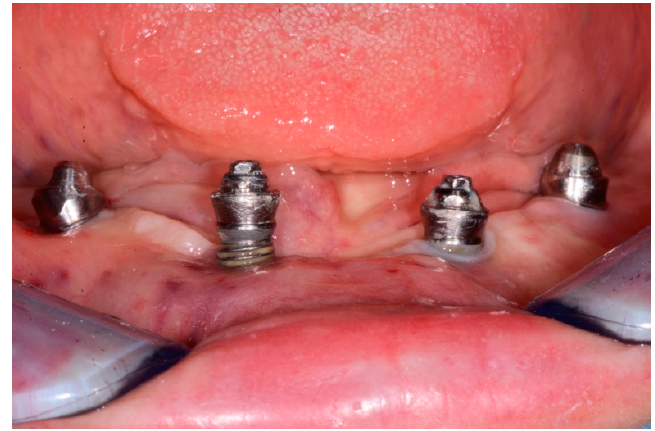
Figure 3. Clinical photograph of the same diabetic patient, showing suppuration and exposure of the implant threads.